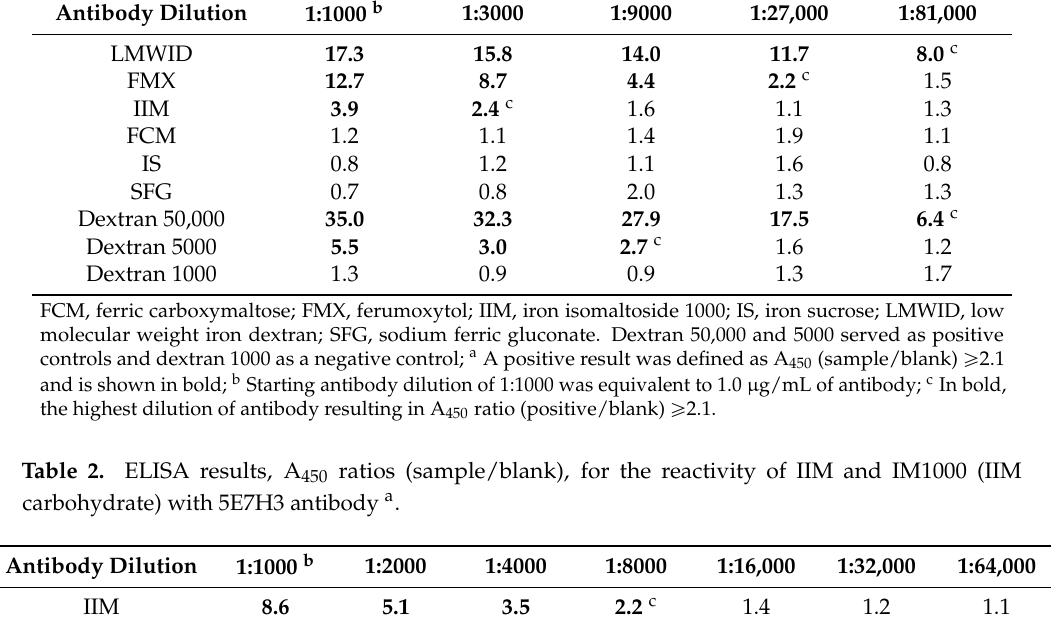
Table 1. ELISA results, A 450 ratios (sample/blank), for the reactivity of different IV iron preparations with 5E7H3 antibody a . Antibody Dilution